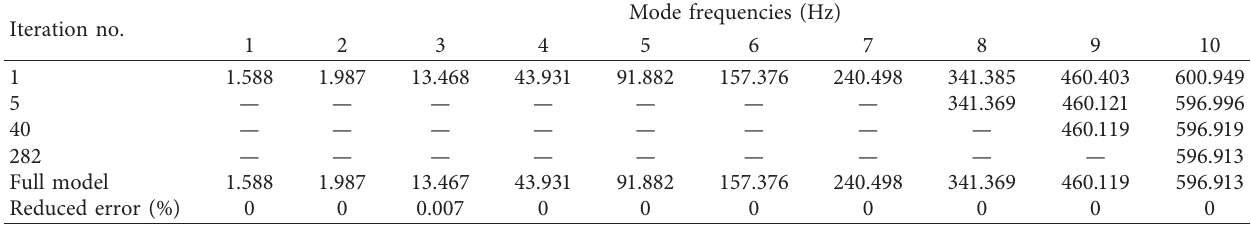
Table 3: Mode frequencies of the reduced model compared to the full model. Iteration no.